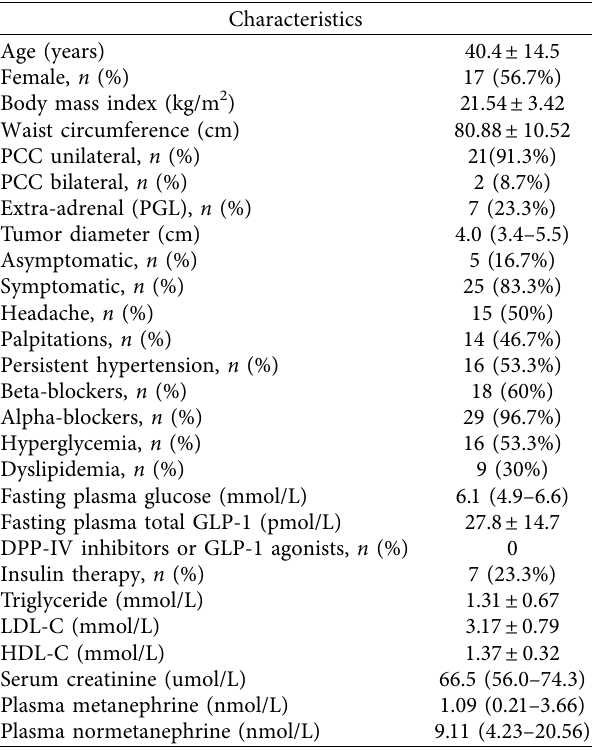
Table 1: Clinical characteristics of patients with PPGL ( n �